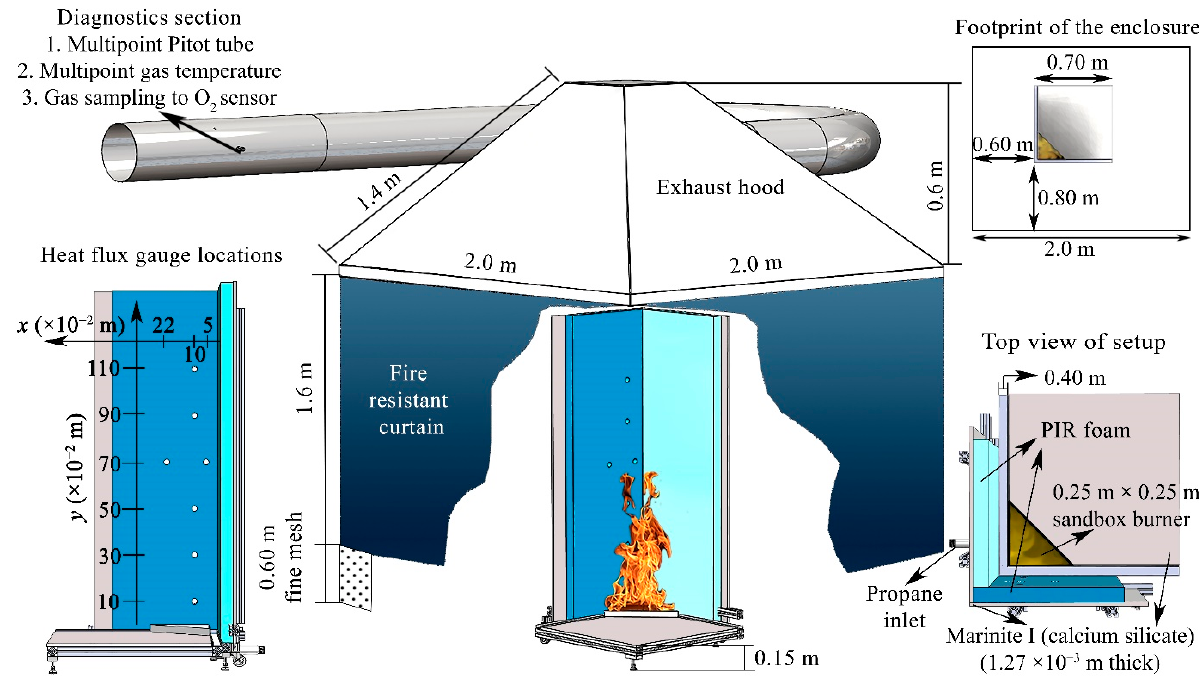
Figure 1. Schematic of the full-scale experiment.